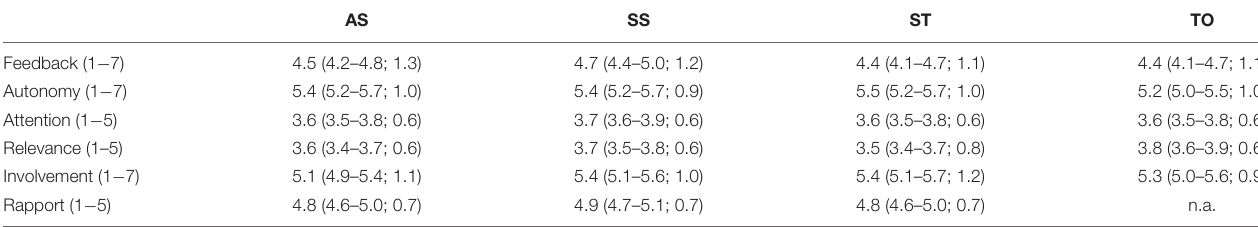
TABLE 4 | Mean scores and standard deviation of the four conditions. AS SS